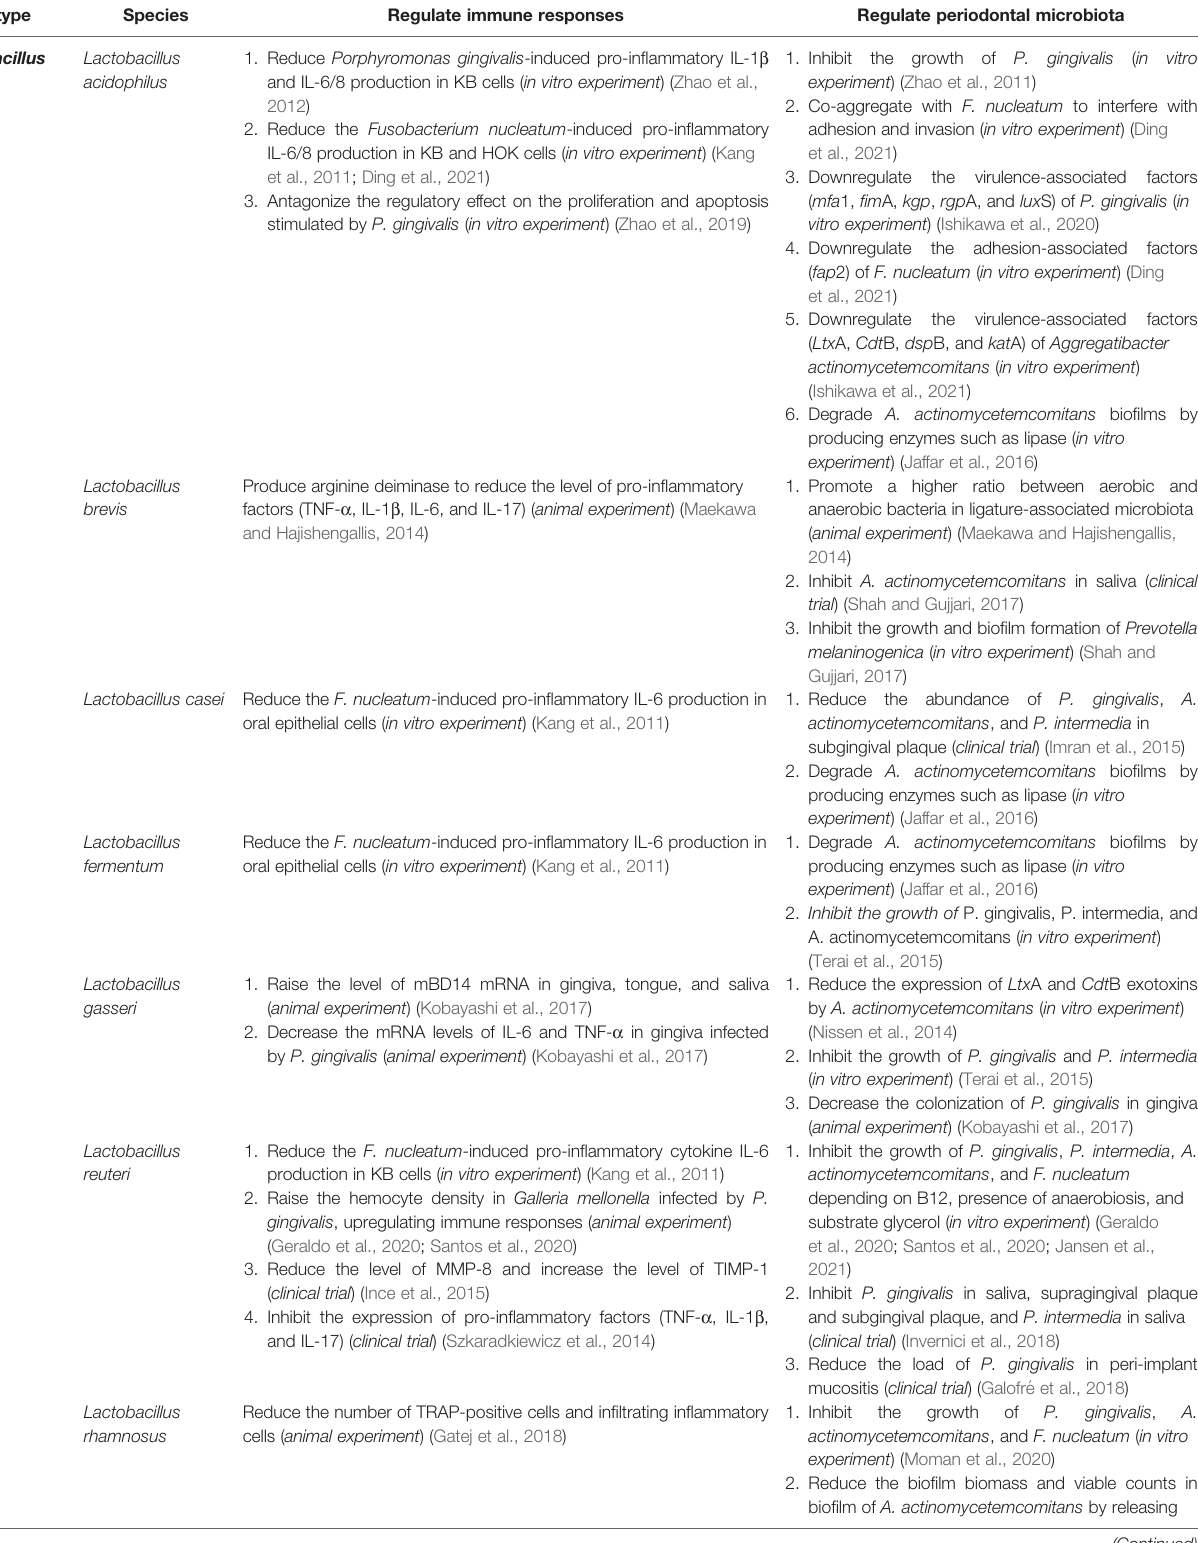
TABLE 1 | The regulatory effects of known probiotic species promoting periodontal